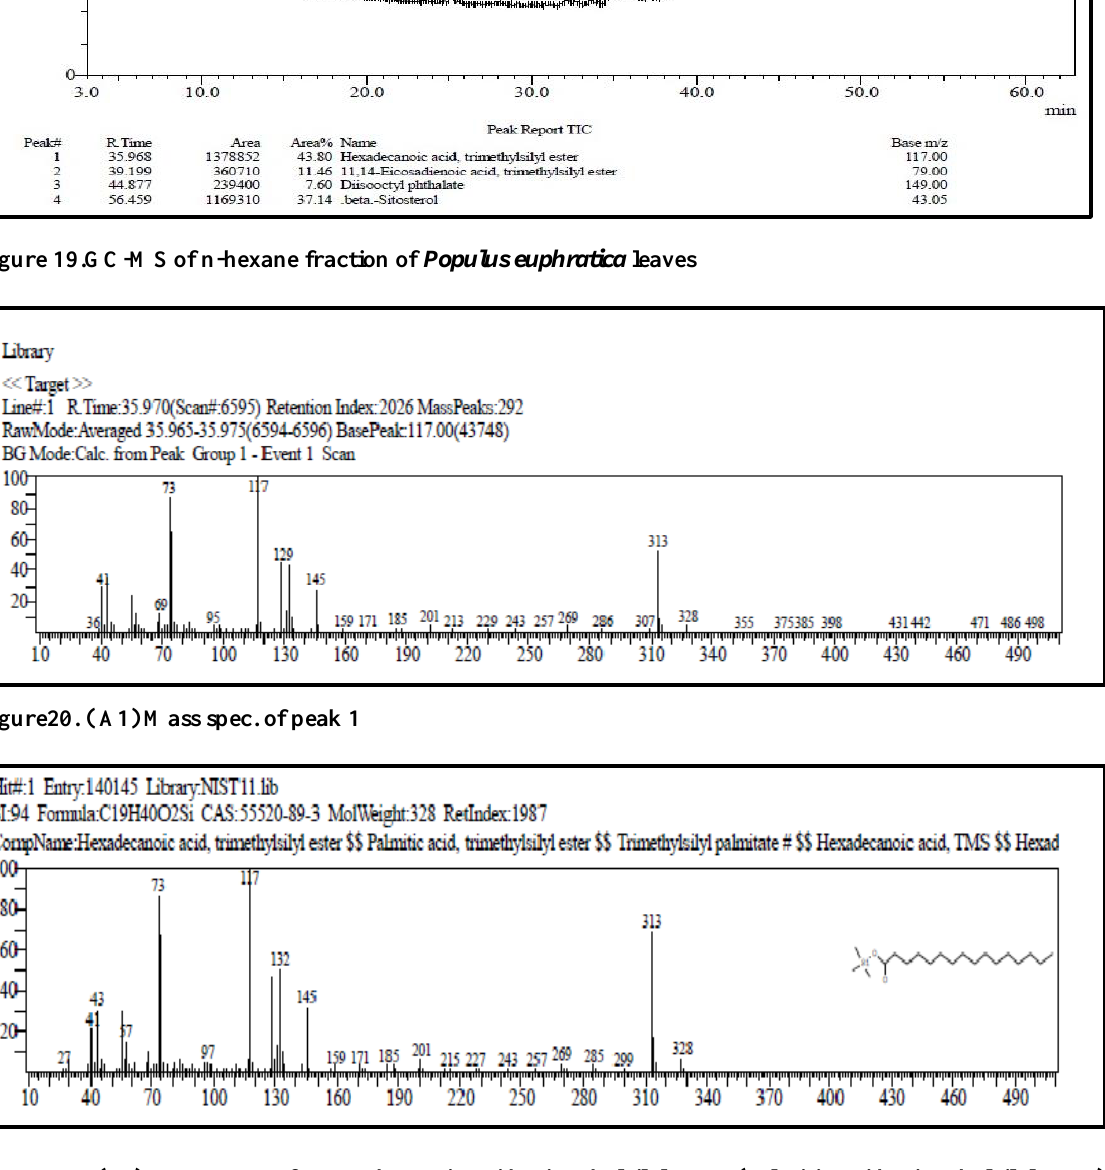
Figure 20. (B1) Mass spec. of Heptadecanoic acid trimethylsilyl ester (palmitic acid trimethylsilyl ester) from NIST Library